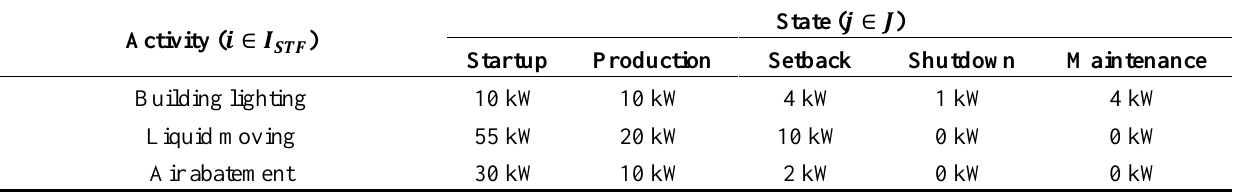
Table 2. Illustrative activities with different energy demand per state.